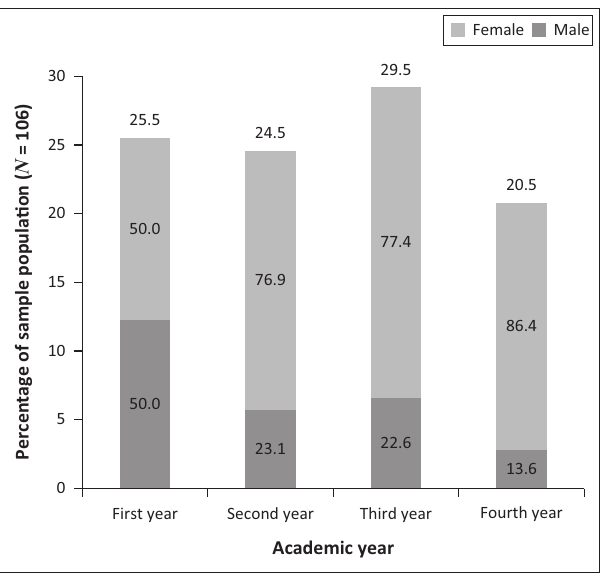
FIGURE 2: Distribution of undergraduate optometry students who participated in the study ( N = 106) with regard to gender and number of students per academic